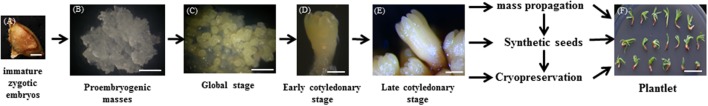
Schematic overview of Somatic embryogenesis in larch (Larix spp.) and applications of somatic embryo. (A,B) proembryogenic masses initiated from immature zygotic embryos. (C–E) The microscopic phenotype of somatic embryos at different development stage. (F) Plantlet of larch. Scale bars (A–C) are 1 mm, (D,E) are 0.2 mm, and (F) is 1 cm.